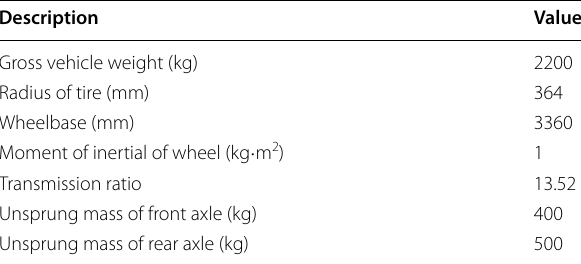
Table 3 Parameters of the used battery electric vehicle